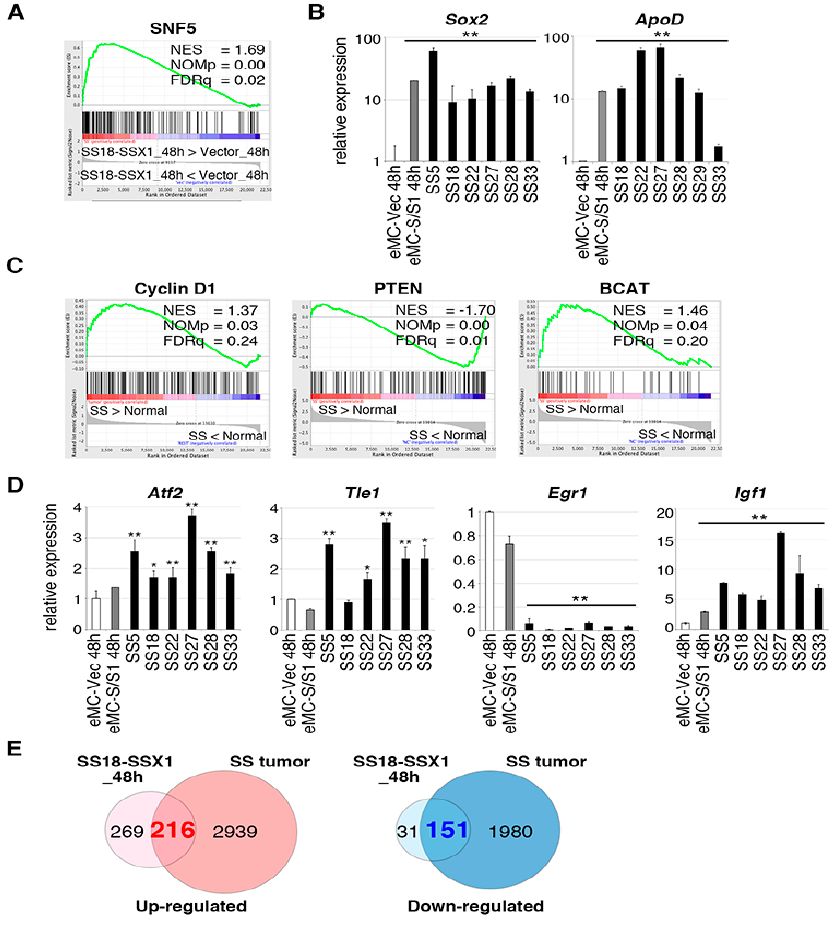
Figure 2. Gene expression profiling of mouse synovial sarcoma and embryonic mesenchymal cells (eMCs) expressing SS18-SSX1 . ( A ) Gene set enrichment analysis (GSEA) of eMCs expressing SS18-SSX1 versus eMCs with an empty vector shows enrichment of the SNF5 pathway. ( B ) Real-time quantitative RT-PCR for Sox2 and ApoD in eMCs with or without SS18-SSX1 , and synovial sarcoma tissues. Expression values were normalized to Gapdh expression. ** p < 0.01. ( C ) GSEA of mouse synovial sarcomas versus mouse normal tissue mix shows enrichment of the Cyclin D1, Phosphatase and Tensin Homolog (PTEN), and β -catenin pathways. ( D ) RT-qPCR for Atf2 , Tle1 , Egr1 , and Igf1 in eMCs with or without SS18-SSX1 , and synovial sarcoma tissues. Expression values were normalized to Gapdh expression. * p < 0.05 and ** p < 0.01. ( E ) Venn diagrams for upregulated and downregulated genes in eMCs expressing SS18-SSX1 (versus eMCs with empty vector) and mouse synovial sarcomas (versus mouse normal tissue mix). Fold changes > 2.0, p <